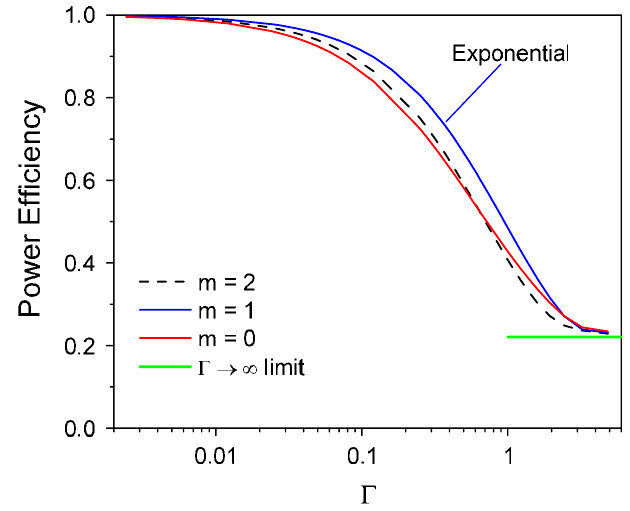
FIG. 7. (Color) The power transmission efficiency as a function of normalized input pulse width (cid:1) for the exponential ( m (cid:2) 1 ), linear ( m (cid:2) 0 ), and m (cid:2) 2 profiles.